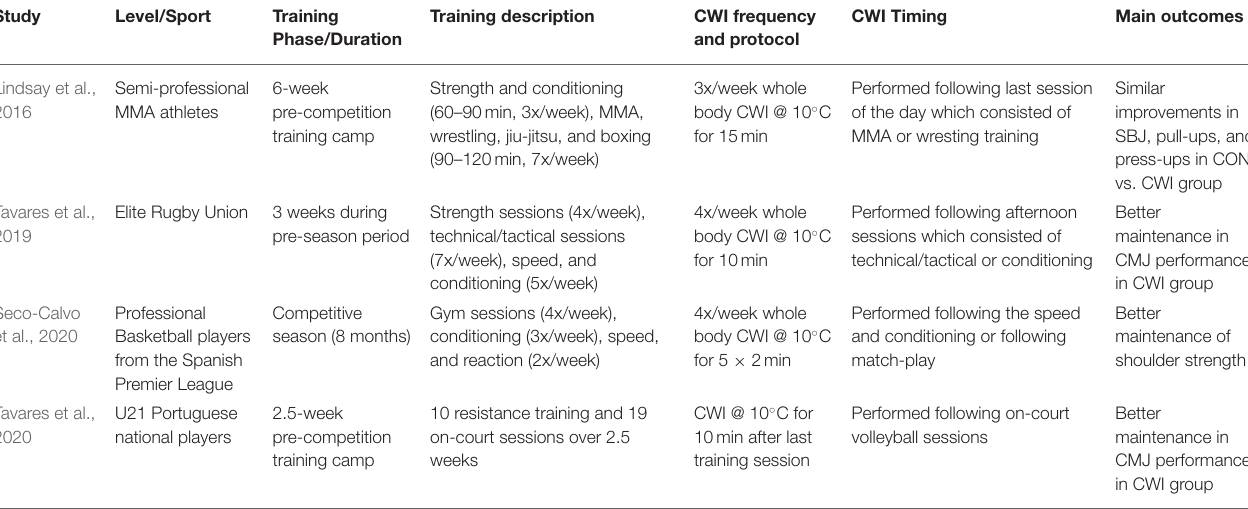
TABLE 1 | Summary of studies examining the longer-term effect of CWI on the recovery of exercise performance.